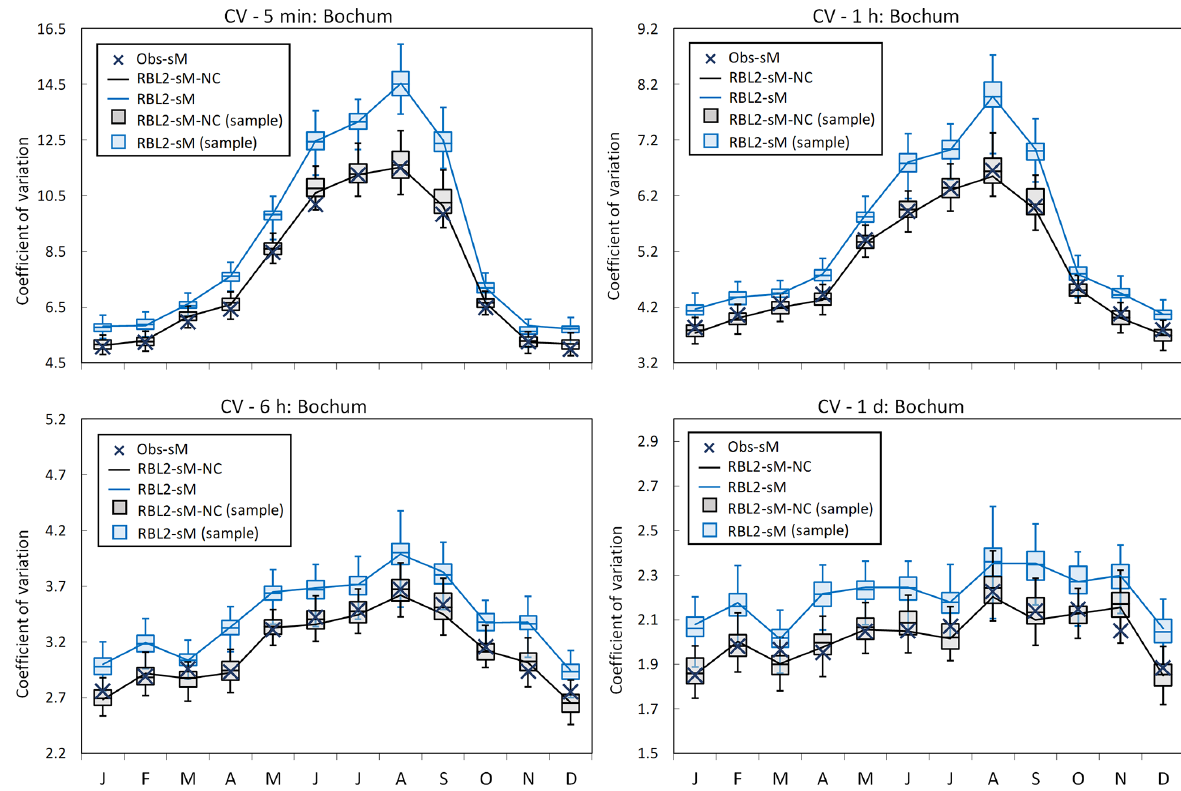
Figure 8. Coefficient of variation (CV) by month at Bochum: the observed vs. the fitted CV using the RBL2 models with the original and the new solution spaces of α (RBL2-sM, light blue lines and boxplots; RBL2-sM-NC, black lines and boxplots).